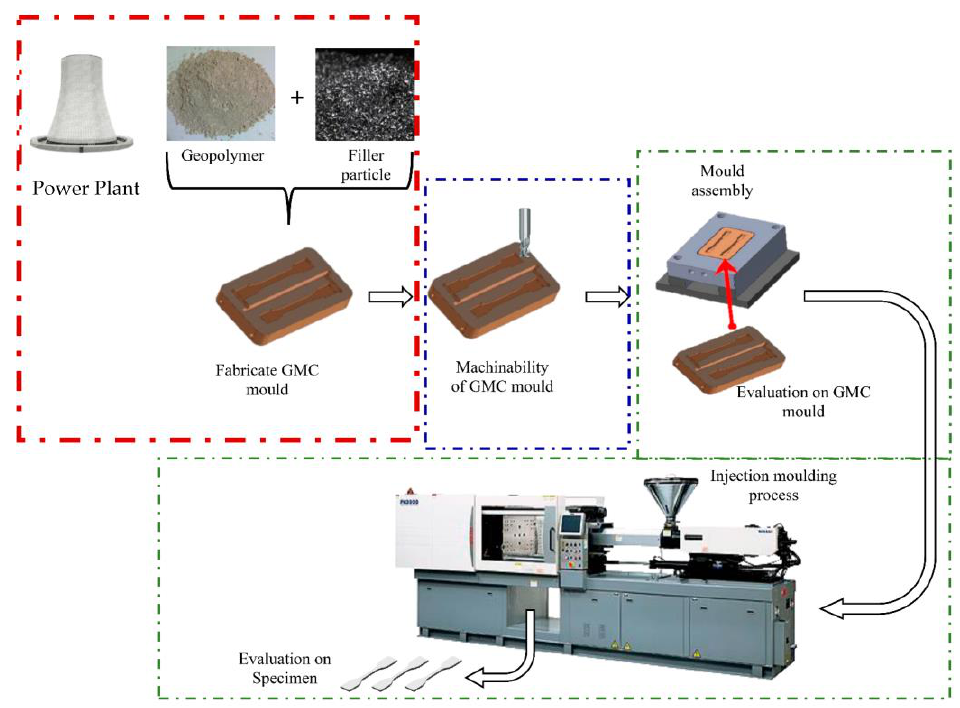
Figure 4. Graphical representation of GGMC as new material for mould inserts.